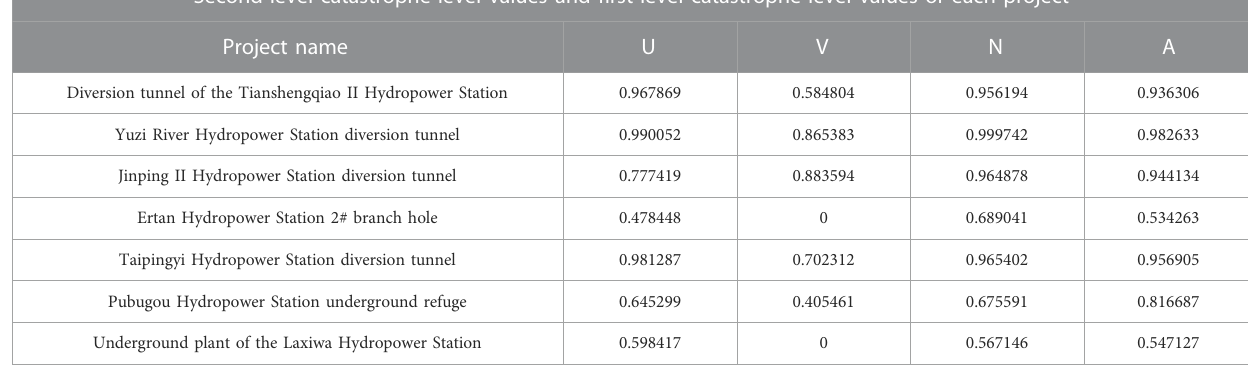
TABLE 8 Second-level catastrophe-level values and fi rst-level catastrophe-level values of each project.